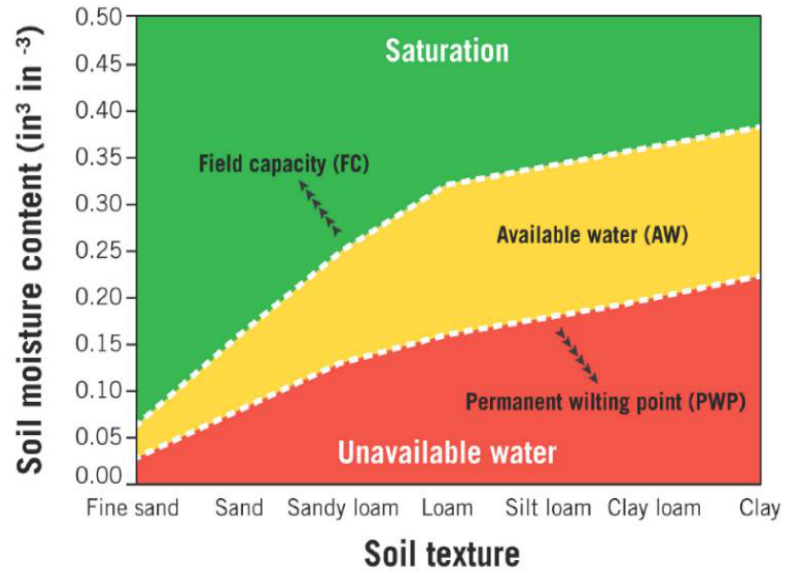
Figure 4. The relationship between soil saturation, field capacity, soil available water, permanent wilting point, soil unavailable water, and soil texture (reproduced upon da Silva et al. [22], with permission) .